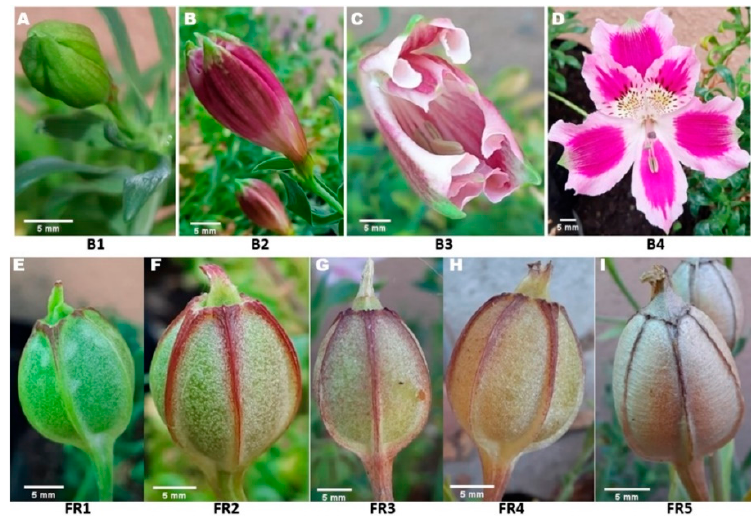
Figure 1. Morphological characterization of the reproductive stages of A. pelegrina . ( A ) = B1: Initiation of flower bud development; ( B ) = B2: Flower bud; ( C ) = B3: Flower bud opening; ( D ) = B4: Anthesis; ( E ) = FR1: Fruit stage 1; ( F ) = FR2: Fruit stage 2; ( G ) = FR3: Fruit stage 3; ( H ) = FR4: Fruit stage 4; ( I ) = FR5: Fruit stage 5. Scale bar: 5 mm. Table 1. Phenological evaluation chart of A. pelegrina reproductive stages.